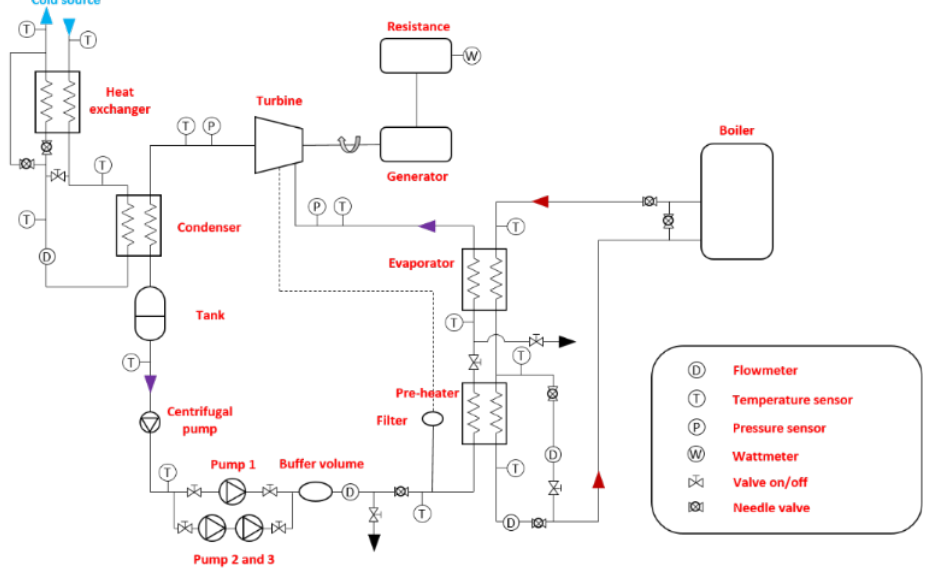
Figure 4. PFD of the experimental ORC.